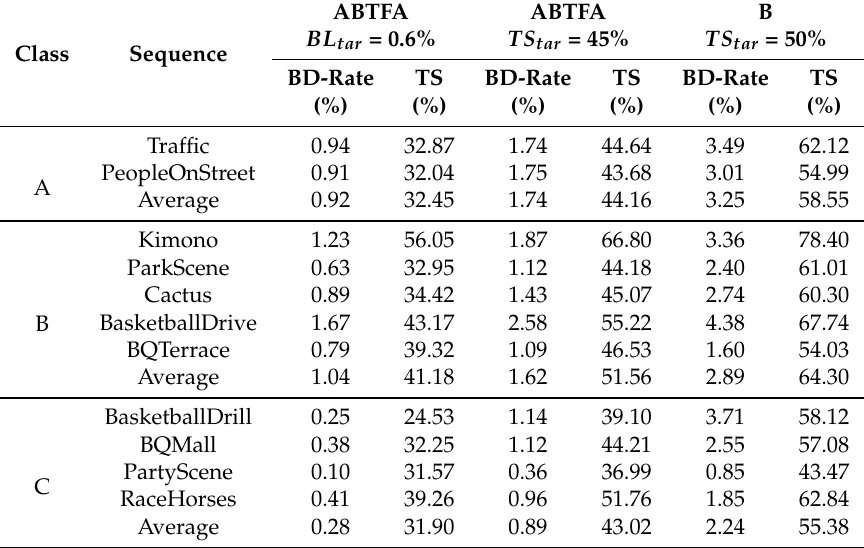
Table 5. BD-rate loss and time saving of advanced bagged trees based fast approach (ABTFA) under different target BD-rate loss constraint and target time saving